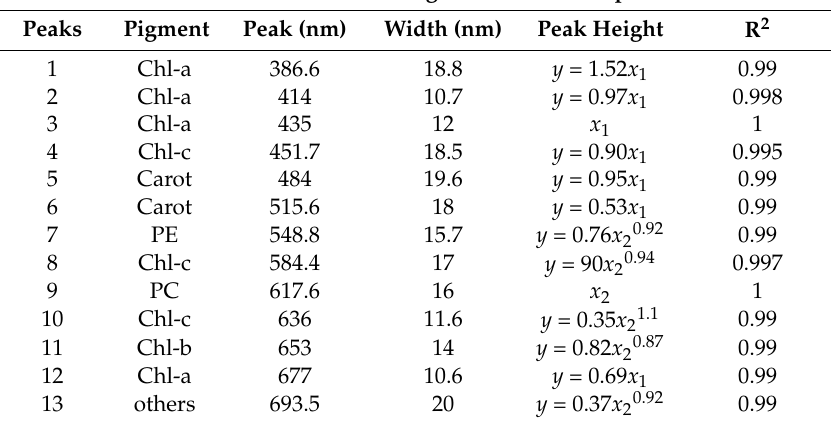
height at 617.6 nm ( x 2